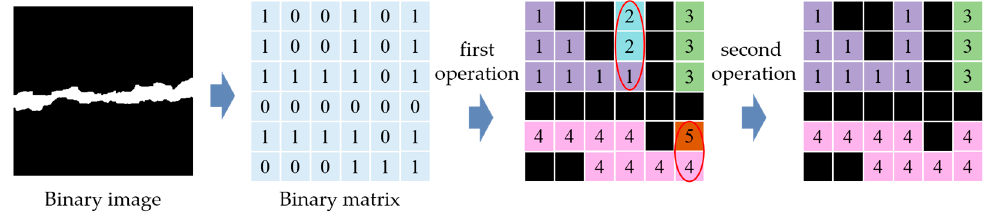
Figure 5. Traditional DTM approach.